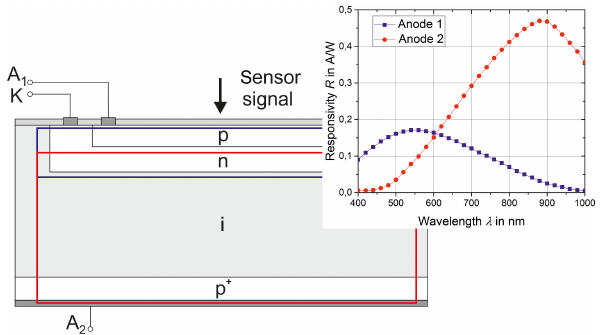
Figure 1. Photodiode structure and spectral responsivity curves of the WSPD (adapted from First Sensor WSPD data sheet, First Sen- sor AG,